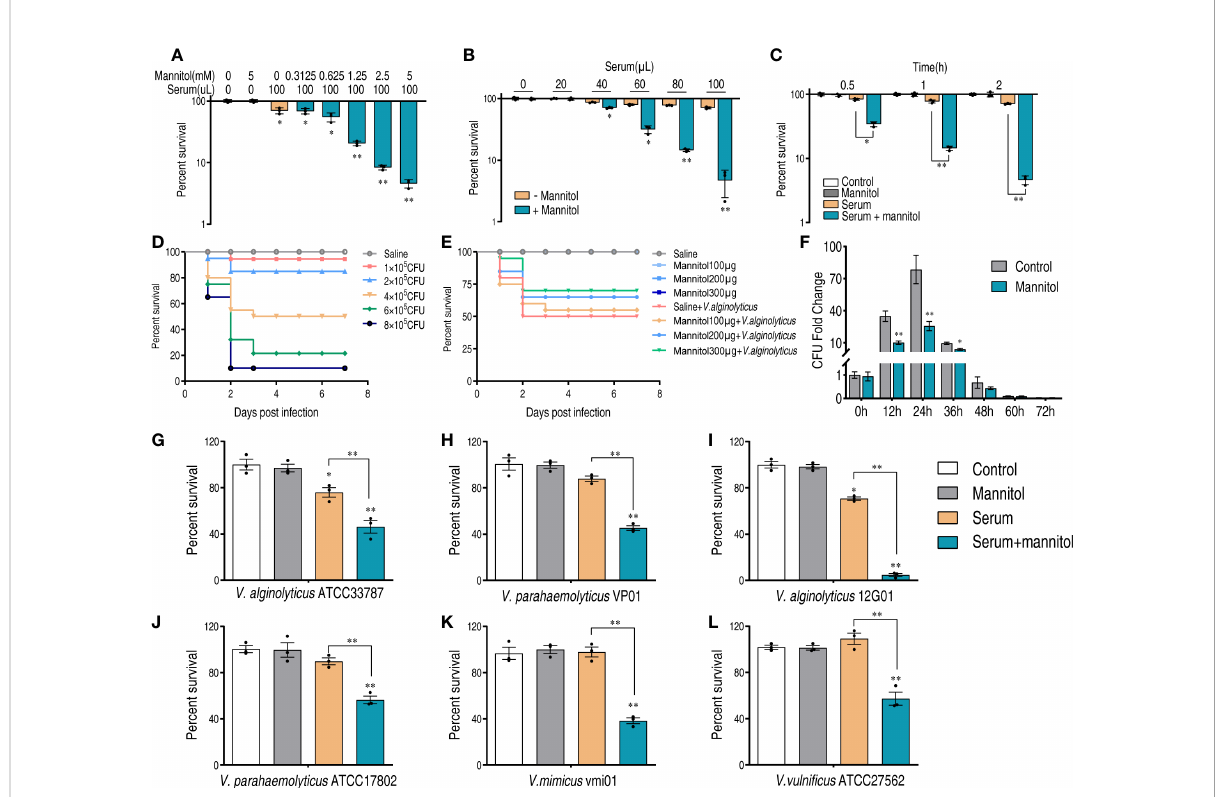
FIGURE 5 Mannitol promotes the killing effect of serum on Vibrios . (A) Synergetic effects of 100 m l serum and mannitol on the viability of V. alginolyticus 12G01 with the indicated dose of mannitol (0 – 5 mM). (B) Percent survival of V. alginolyticus 12G01 incubated with 5 mM mannitol plus serum (0 – 100 m l) or without mannitol. (C) Percent survival of V. alginolyticus 12G01 in the presence of 5 mM mannitol or/and 100 m l serum for the indicated length of time. (D) Determination of LD50 of D. rerio infected with V. alginolyticus . Mortality was monitored for 14 days (only 7 days are shown as no death was observed after 7 days). (E) Percent survival of D. rerio challenged with V. alginolyticus , which received mannitol treatment at 1, 4, 10, and 20 h post-infection. Mortality was monitored for 14 days (only 7 days are shown as no death was observed after 7 days). (F) The amounts of bacteria in each fi sh after being treated with or without mannitol (300 m g) and infected with a sublethal dose of bacterial challenge. (G – L) Percent survival of V. alginolyticus ATCC33787 (G) , V. parahaemolyticus VP01 (H) , V. alginolyticus 12G01 (I) , V. parahaemolyticus ATCC17802 (J) , V. mimicus vmi01 (K) , and V. vulni fi cu ATCC27562 (L) in the presence of 5 mM mannitol or/and 100 m l serum. The results are displayed as means ± SEM, and signi fi cant differences are identi fi ed (* p < 0.05 and ** p < 0.01) as determined by Student ’ s t -test. At least three biological repeats were carried